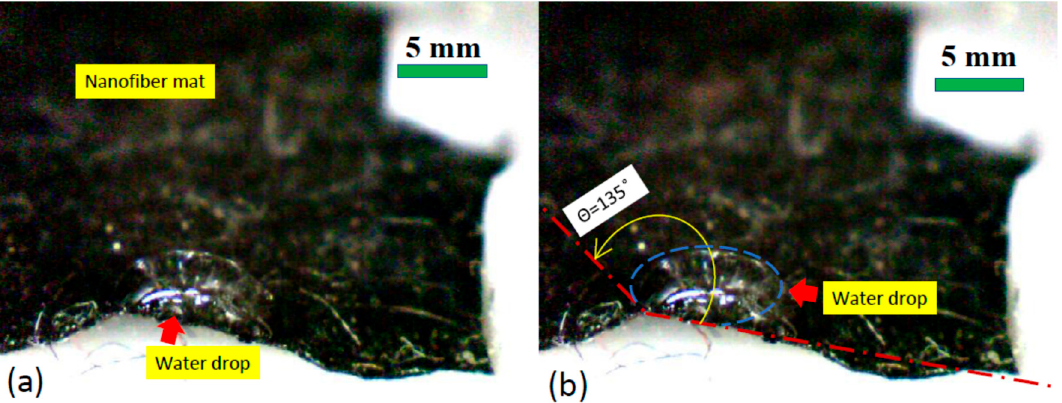
Figure 9. Images showing the contact between water and the composite carbon fiber: ( a ) water drop just setting at the edge of the fiber mat; ( b ) contact angle measured after 60 min.